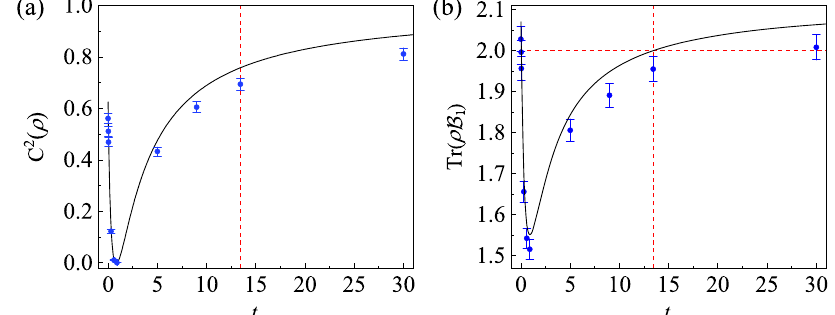
Fig. 4 Experimental results of concurrence and violations of the CHSH inequality. a Squared concurrence versus the parameter t of a two- qubit state. For 0 ≤ t < 0.791 and t > 0.865, ρ is entangled as squared concurrence C 2 ( ρ ) > 0. For 0.791 ≤ t ≤ 0.865, ρ is separated as C 2 ( ρ ) = 0. b Violations of the CHSH inequality versus t . The other parameters of the state and the detection ef fi ciency are fi xed as s = 1/50, τ = 1/2, and η = 3/4. Bell nonlocal states with 0 ≤ t ≤ 0.038 and t > 13.428 violate the CHSH inequality. Symbols are experimental data, which agree with their theoretical predictions (solid